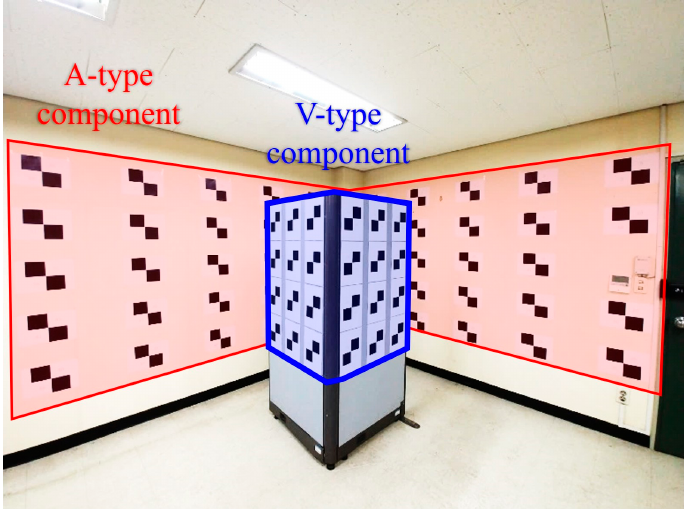
Figure 4. Established test-bed for real experiments.